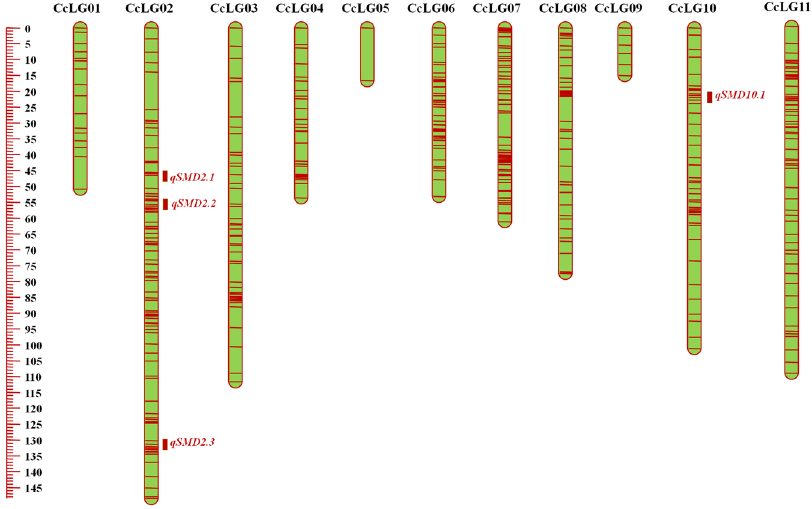
Figure 4. Genetic and QTL map constructed using 484 SNPs and of 798.25 cM length in ICPL 20097 × ICP 8863 (PRIL_C) population in pigeonpea. The scale on left side represents map distance in cM. The eleven linkage groups are shown as vertical bars and each horizontal line on the bar represent single SNP marker. Aggregation on horizontal lines indicate higher marker density on that particular linkage group. Three and one rectangles on right side of CcLG02 and CcLG10 represent the four QTLs identified for SMD resistance in PRIL_C